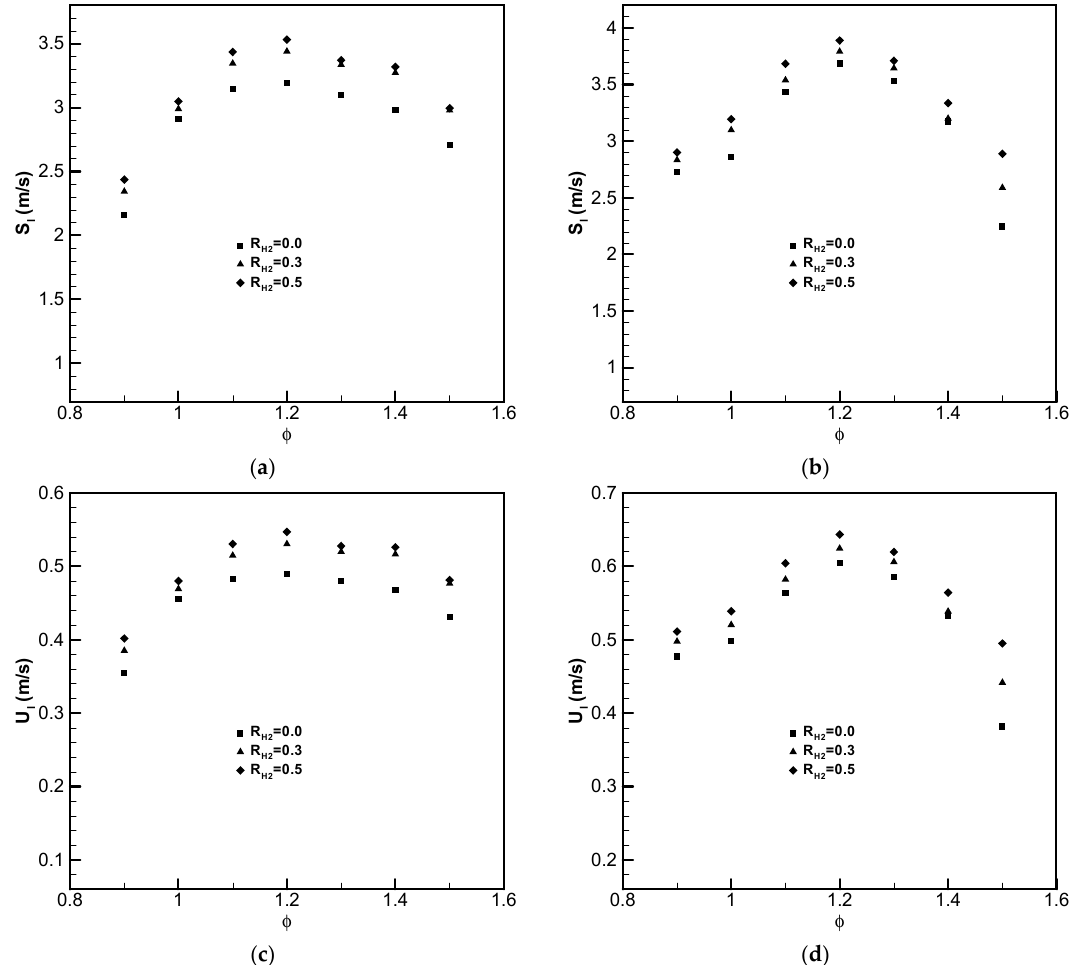
Figure 8. Effect of hydrogen addition on S l and U l versus equivalence ratio. ( a ) T = 390 K; ( b ) T = 420 K; ( c ) T = 390 K; ( d ) T = 420 K.